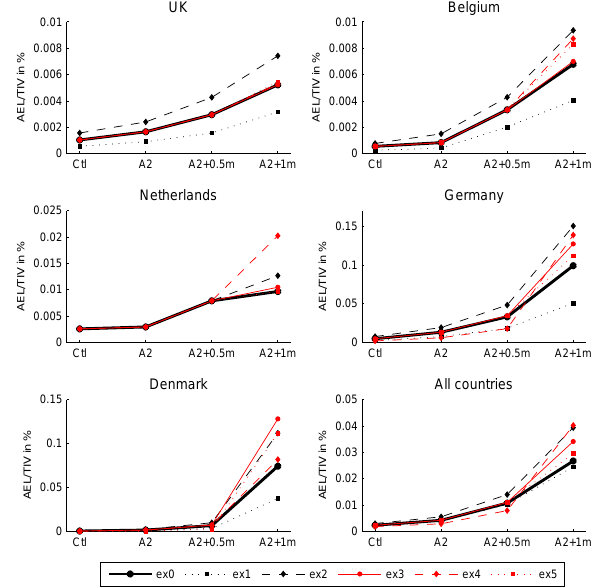
Fig. 7. Loss model sensitivity to the failure probability parameters illustrated by the AEL/TIV ratios for the Ctl and the A2 + SLR scenarios. For experiment description see text and Table 2.